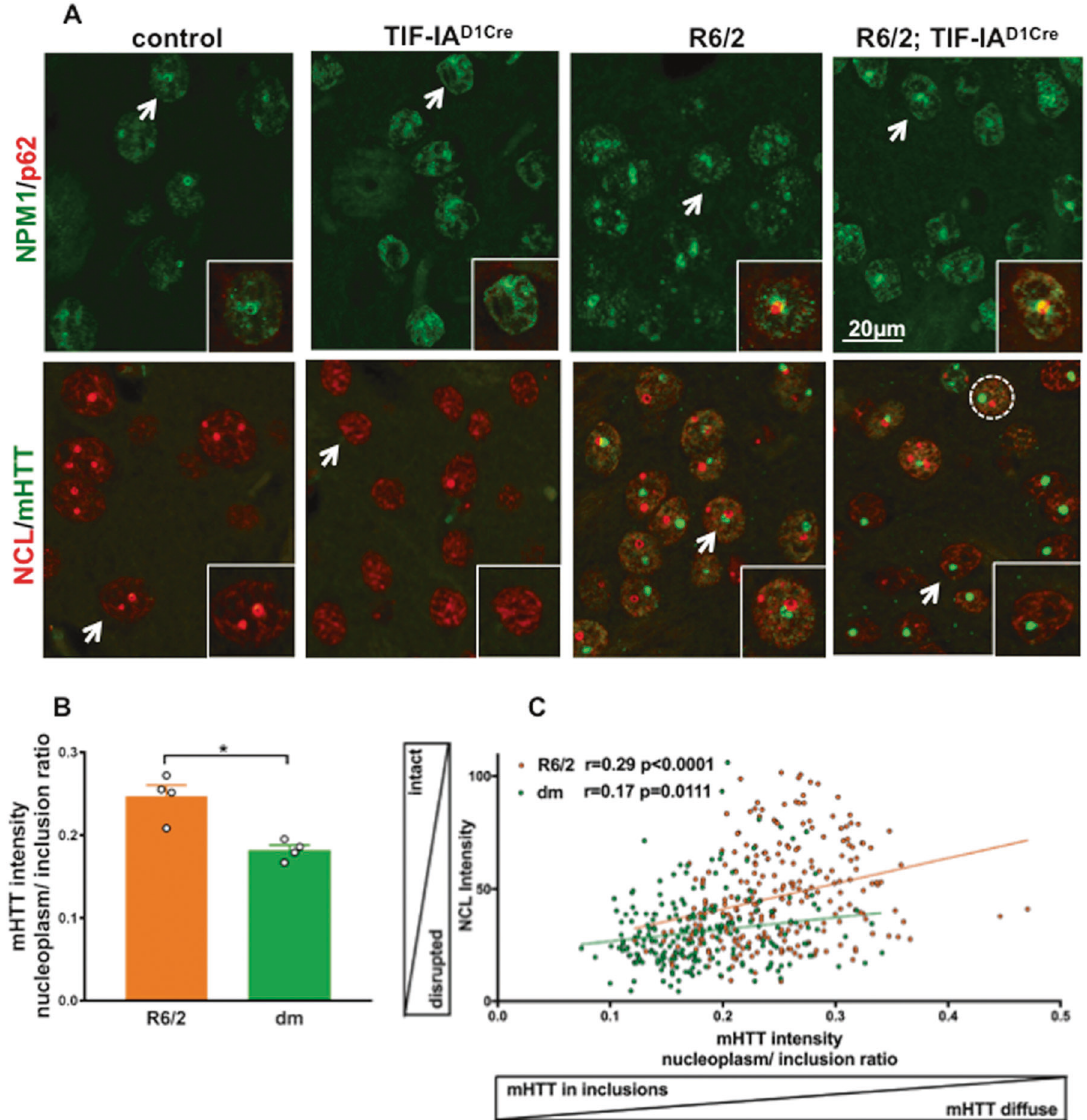
Fig. 2 Delocalization of NPM1 and NCL and altered nuclear distribution of mHTT inclusions upon irreversible induction of nucleolar stress in striatal neurons. A Representative confocal images of striatal sections from control, TIF-IA D1Cre , R6/2 and R6/2; TIF-IA D1Cre double mutant (dm) mice at 9 weeks co-immunostained with antibodies against the nucleolar marker NPM1 and NCL, and p62 and mHTT (EM48), respectively. Insets are high magni fi cation of the nuclei highlighted by the white arrow. Scale bar: 20 µm, 10 µm (insets). B mHTT nuclear distribution measured as the ratio between mHTT mean intensity in the nucleoplasm and in the nuclear inclusions in R6/2 (N = 4) and dm (N = 4) mice. mHTT intensity in the nucleoplasm of dm is signi fi cantly lower in comparison with R6/2 mice (Mann – Whitney U test, p = 0.03). C Higher nucleolar integrity assessed by NCL intensity in the nucleus correlates with a higher nucleoplasm/inclusion mHTT intensity ratio in R6/2 (n: number of nuclei = 335, N: number of mice = 4) and dm mice (n: number of nuclei = 296, N: number of mice = 4); ( p < 0.0001 for R6/2 and dm; Pearson coef fi cient r for R6/2 is 0.67 and for the dm